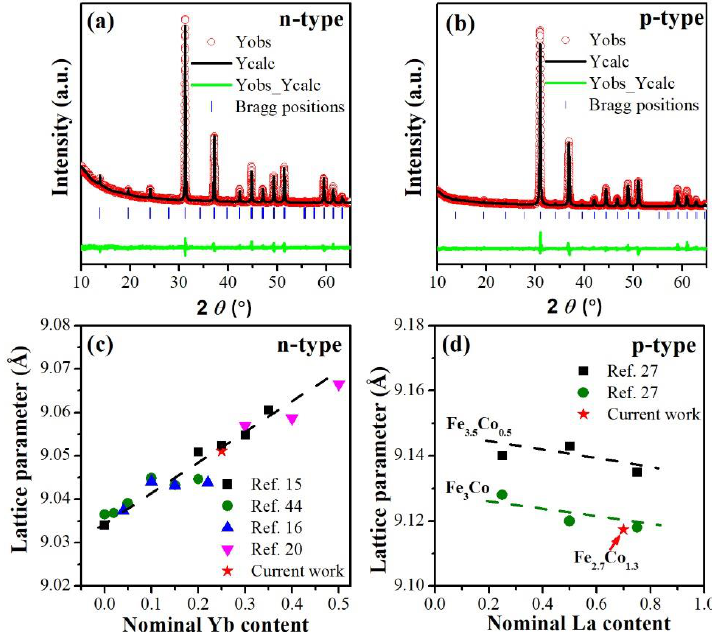
Figure 1. The Rietveld refinement of ( a ) n-type Yb 0.25 Fe 0.25 Co 3.75 Sb 12 and ( b ) p-type La 0.7 Ti 0.1 Ga 0.1 Fe 2.7 Co 1.3 Sb 12 , and lattice parameters of ( c ) n-type Yb 0.25 Fe 0.25 Co 3.75 Sb 12 and ( d ) p-type La 0.7 Ti 0.1 Ga 0.1 Fe 2.7 Co 1.3 Sb 12 . The comparison data are from References [15,16,20,27,44].